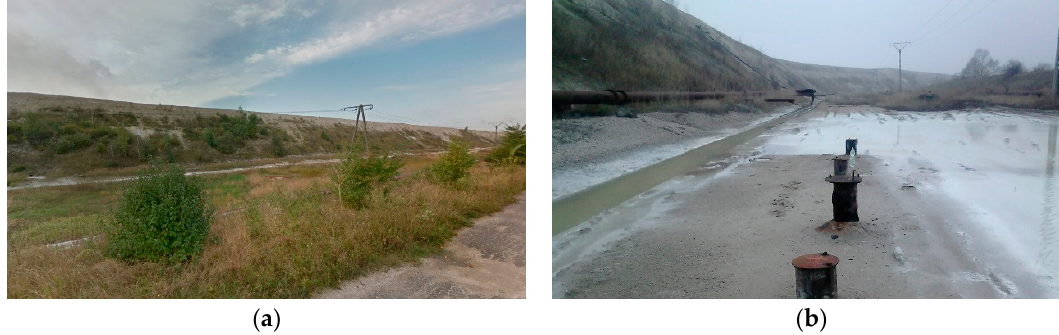
Figure 2. Heaps formed by sedimentary ponds: view from the north-east corner ( a ) and from the north, near piezometer W2 ( b ). In Figure 2b there is visible flooding area, which began to appear as the height of heaps increased. Source: own study.